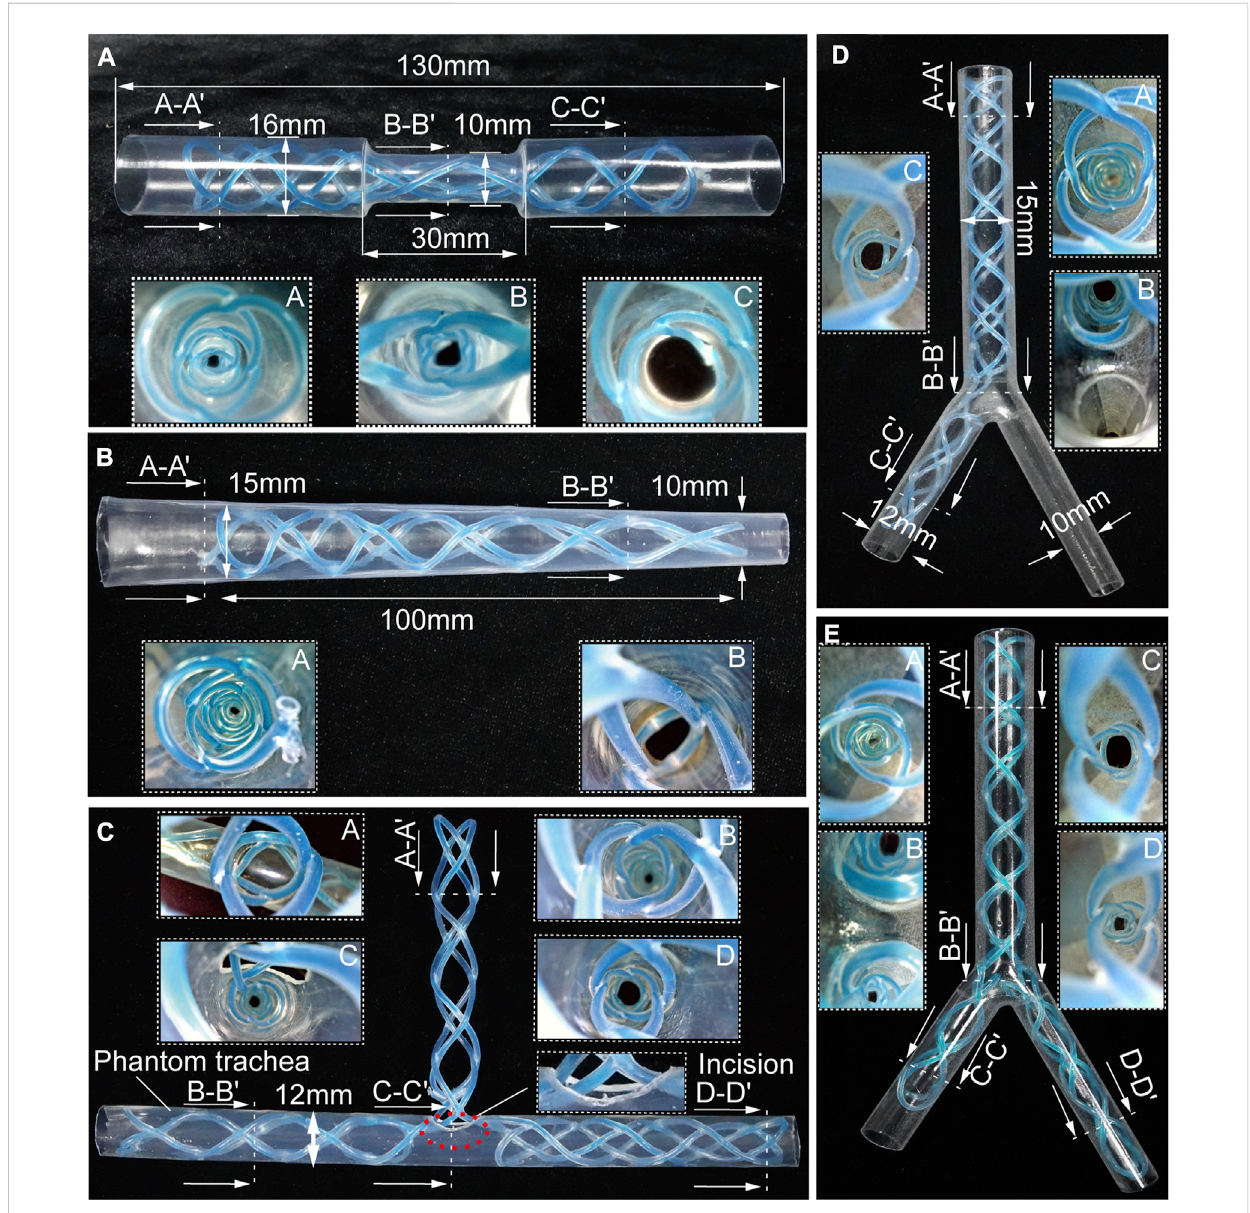
FIGURE 4 Benchtop experiments. Different shapes of the stents cured inside the corresponding phantom tracheal models with endoscopic views. (A, B) Molded straight stents inside tracheal phantom model with insets showing endoscopic views. (C – E) Molded complicated-shaped stents inside a phantom model of tracheal and bronchi with insets showing endoscopic